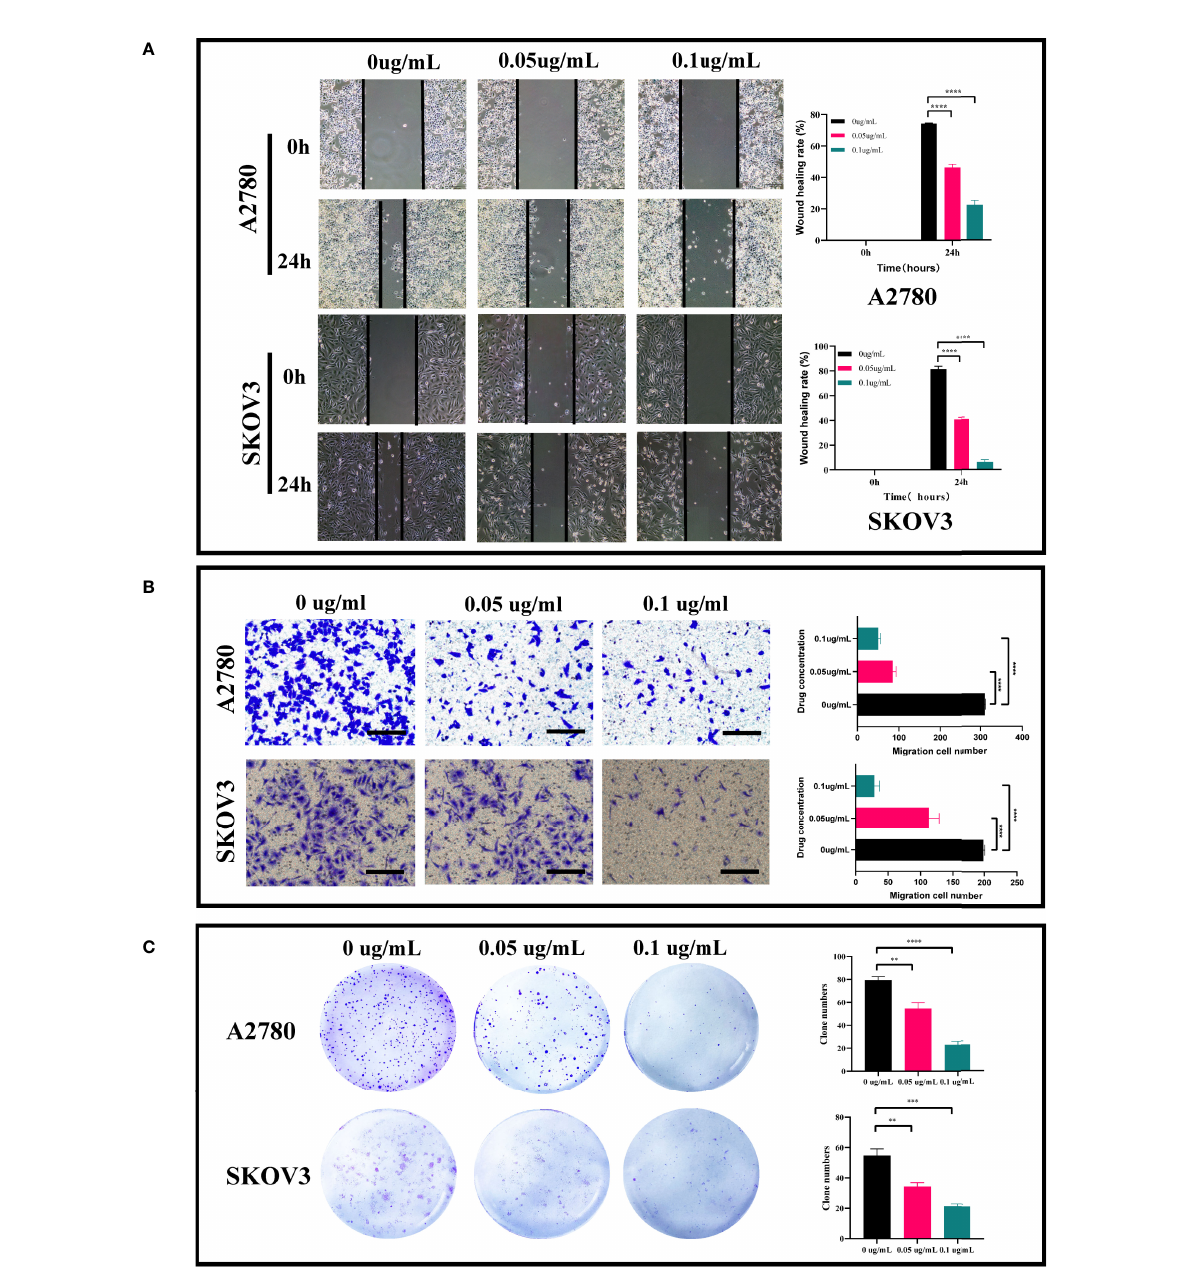
FIGURE 3 Effect of PEI-Pt NCs treatment on migration and clonogenic ability of ovarian cancer cells. (A) Wound healing assay and analysis results of A2780 and SKOV3 cell lines. Cell migration rates were measured at 0h, 24h and 48h, respectively, and histograms show migration rates. (B) Transwell assay and analysis results of A2780 and SKOV3 cells. cell migration was measured at 24h after 0.05ug/mL and 0.1ug/mL treatment, respectively, and the histograms show the migration rates. (C) Clonogenic assay and analytical results of A2780 and SKOV3 cell lines. The number of clonogenic cell clusters was measured on day 10 after 0.05ug/mL and 0.1ug/mL treatment. (* p < 0.05, ** p < 0.01, **** p <